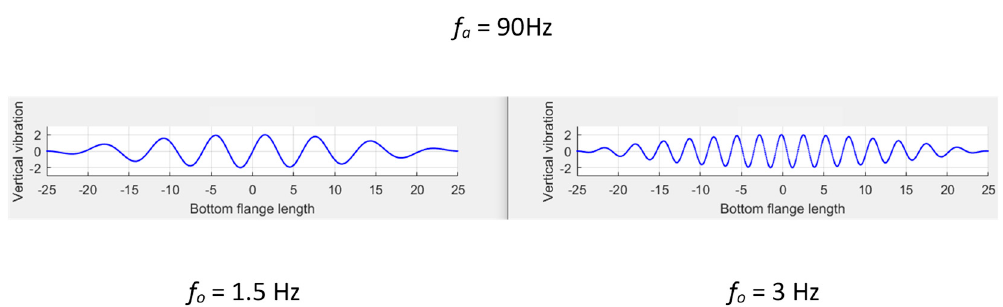
Figure 9. Angular Distance vs. Angular Frequency.